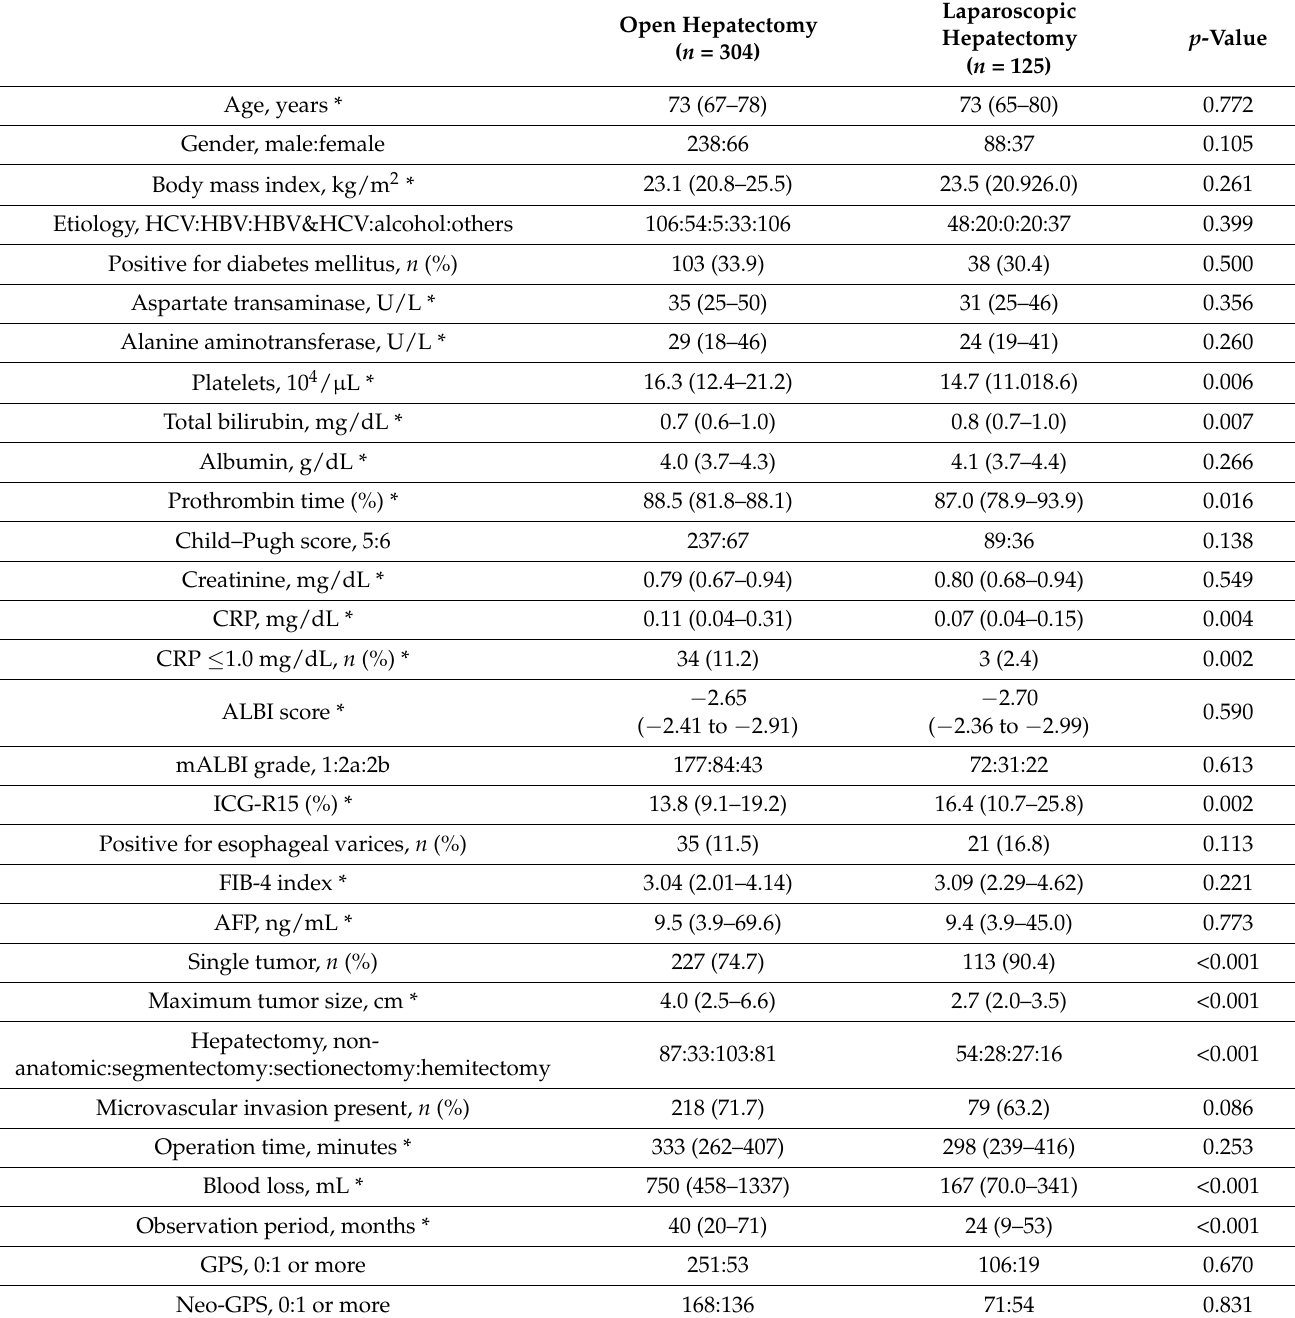
Table 2. Clinical features of patients in open and laparoscopic hepatectomy groups. Laparoscopic Open Hepatectomy ( n = 304)